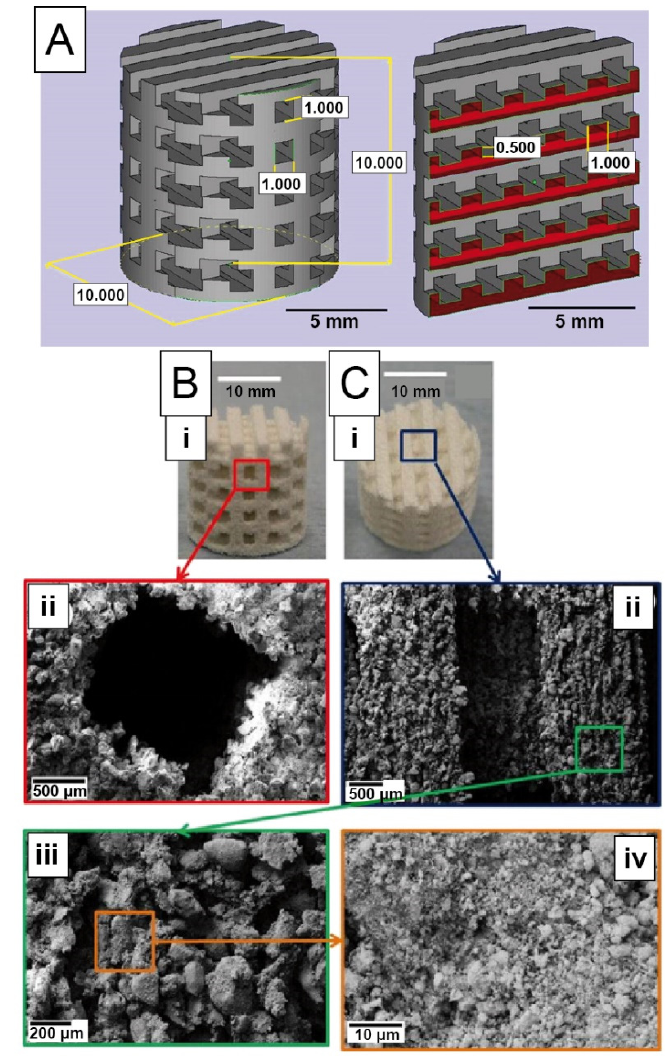
Figure 2. Scaffolds containing 50 wt.% hydroxyapatite nanoparticles suspended in poly(vinyl alcohol) as matrix material. ( A ) CAD design of a layered scaffold showing porous structures in the cylinder. Extrusion printed scaffolds after drying and thermal curing in side-view ( B ( i )) with higher magnification of a channel pore ( B ( ii )), and in top view ( C ( i )) with higher magnification of a channel ( C ( ii )), showing individual hydroxyapatite particle agglomerates ( C ( iii ) ,C ( iv )). Reprinted and adopted with permission from ref. [50]. Copyright 2015 Elsevier.